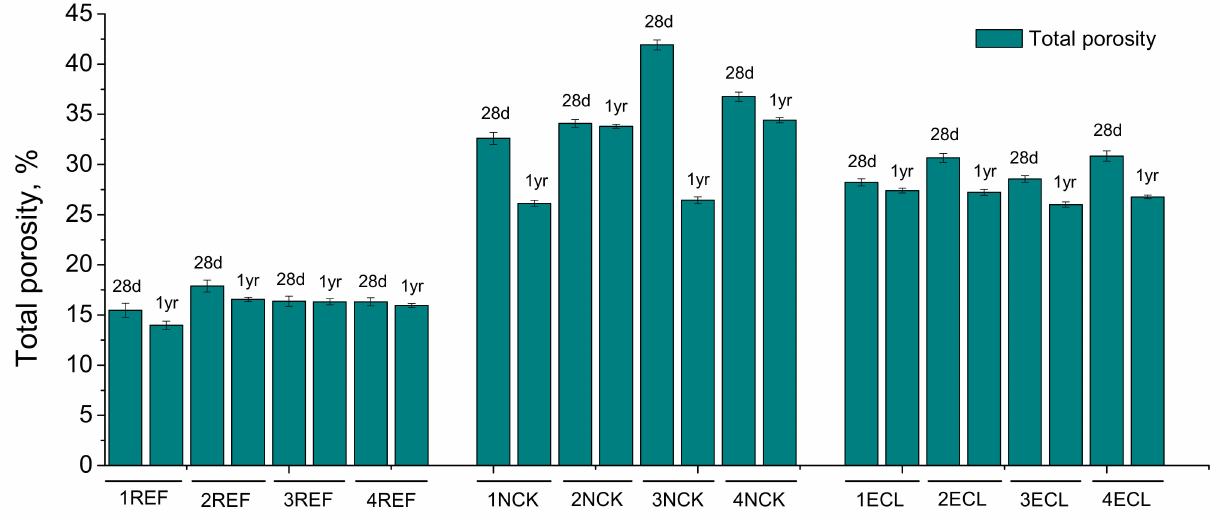
Figure 2. Total porosities obtained for the tested